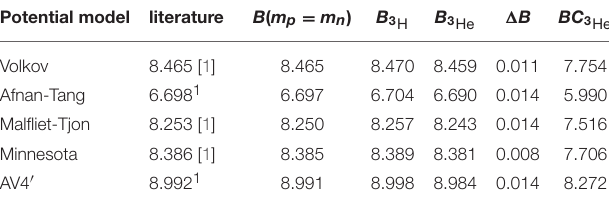
TABLE 8 | The 3 H binding energy obtained using m n and 3 He binding energies calculated taking into account the difference of masses but no Coulomb interaction in 3 He ( B 3 H and B 3 He ), the difference B 3 He , and the 3 He binding energy calculated including also the B 3 H 1 B − = (point) Coulomb interaction ( BC 3 He ). Potential model